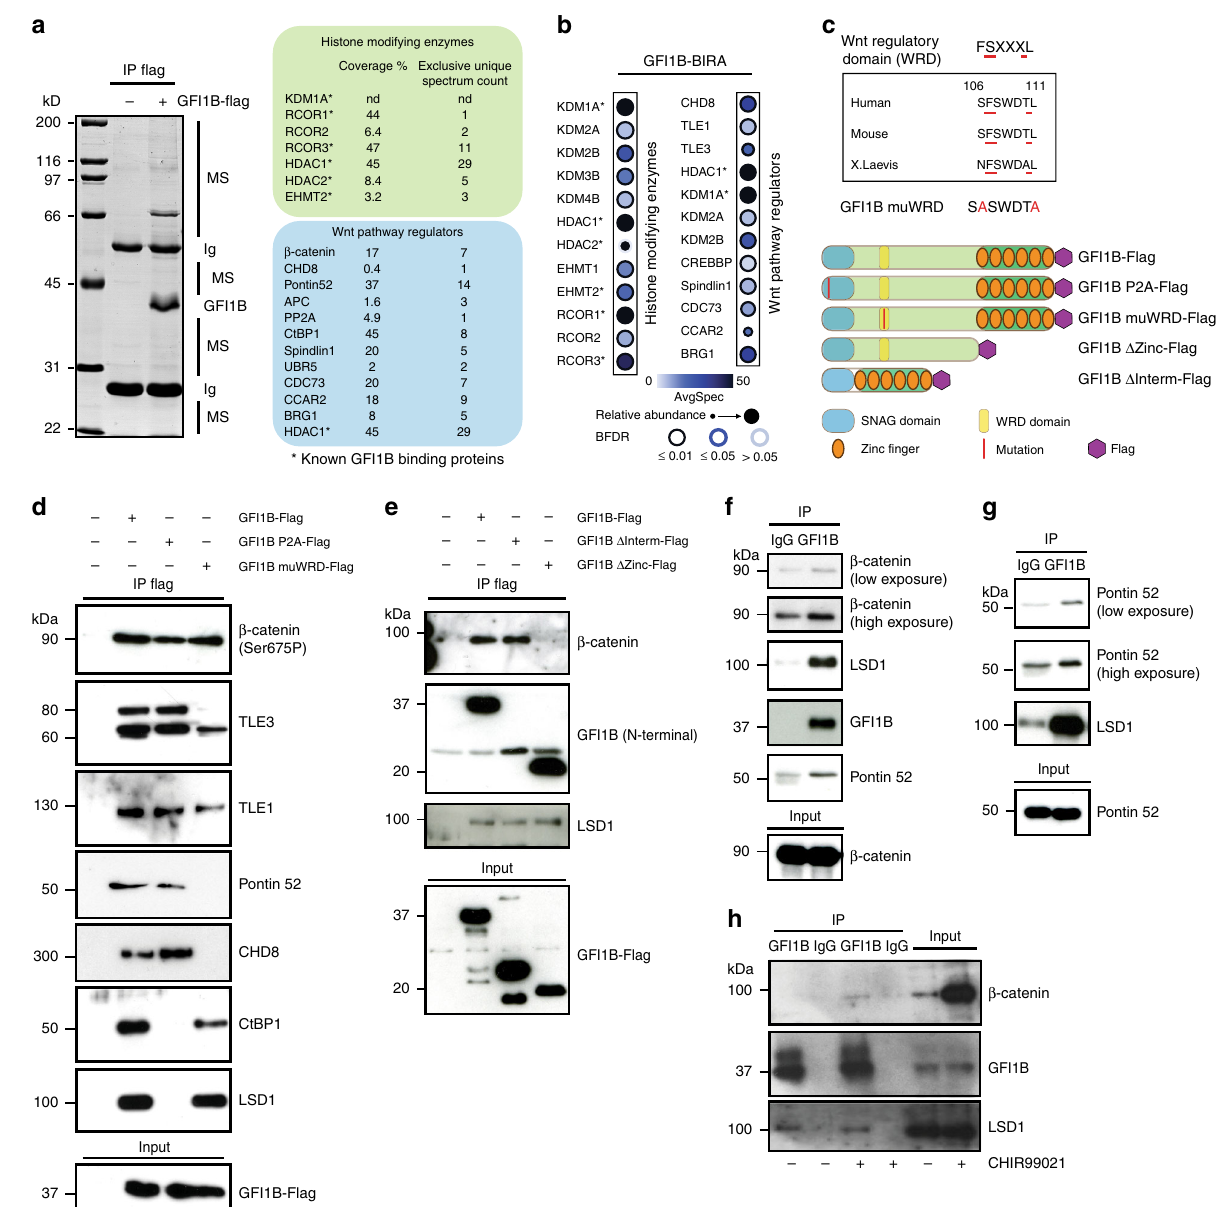
Fig. 2 GFI1B interacts with β -catenin and several regulators of the Wnt/ β -catenin signaling pathway. a Immune precipitation (IP) with anti Flag antibody from 293T cells overexpressing GFI1B-Flag followed by mass spectrometric analysis. b Dot Plot showing BioID interactions of GFI1B-BirA*-Flag with the indicated Histone modifying enzymes and Wnt pathway regulators in Flp-In T-REx HEK293 cells. Node color represents the average spectral counts. The edge color depicts the con fi dence score of the interaction (BFDR ≤ 1% as high con fi dence, 1% < BFDR ≤ 5% as medium con fi dence or 5% < BFDR as low con fi dence score). The relative abundance of prey across the bait is represented by the size of the circle. c A previously described Wnt regulatory domain (WRD) is present in GFI1B 28 . The indicated Flag-tagged and mutated forms used for IP. d , e Immune precipitation with anti Flag antibodies from 293T cells overexpressing WT or the indicated mutated forms of GFI1B followed by western blot. f – h Immune precipitation with an anti GFI1B antibody from K562 ( f